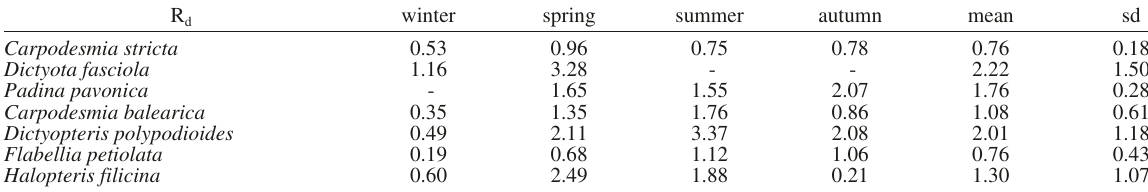
, in mg O gAFDW –1 h –1 ) for species and season. d 2